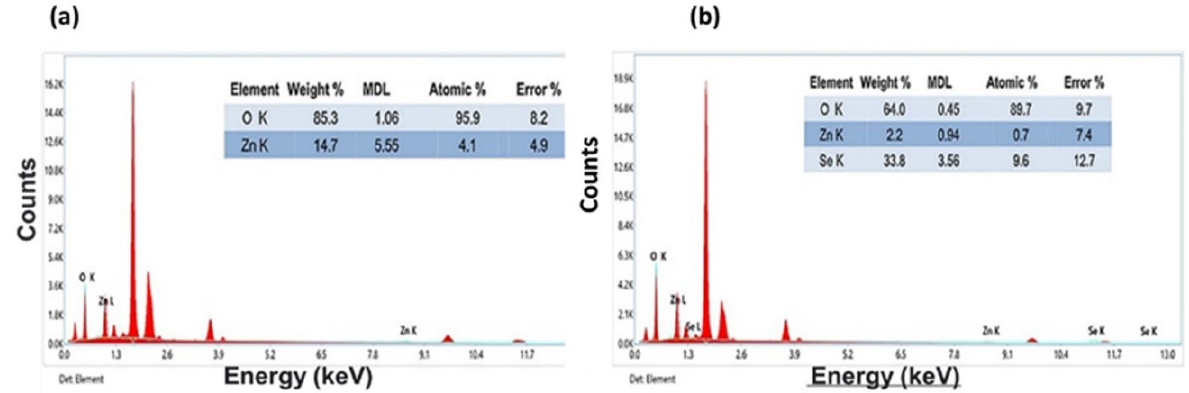
Figure 5. EDX analysis of ( a ) ZnO NPs and ( b ) Se/ZnO NPs.